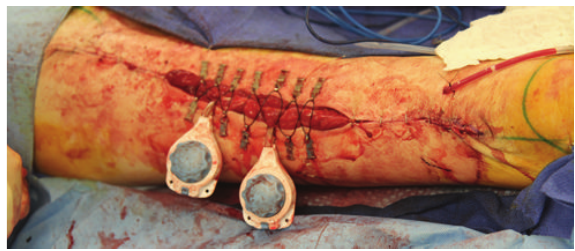
Figure 2: External tissue expanders applied to aid in closure of donor site where approximation with staples was not possible.